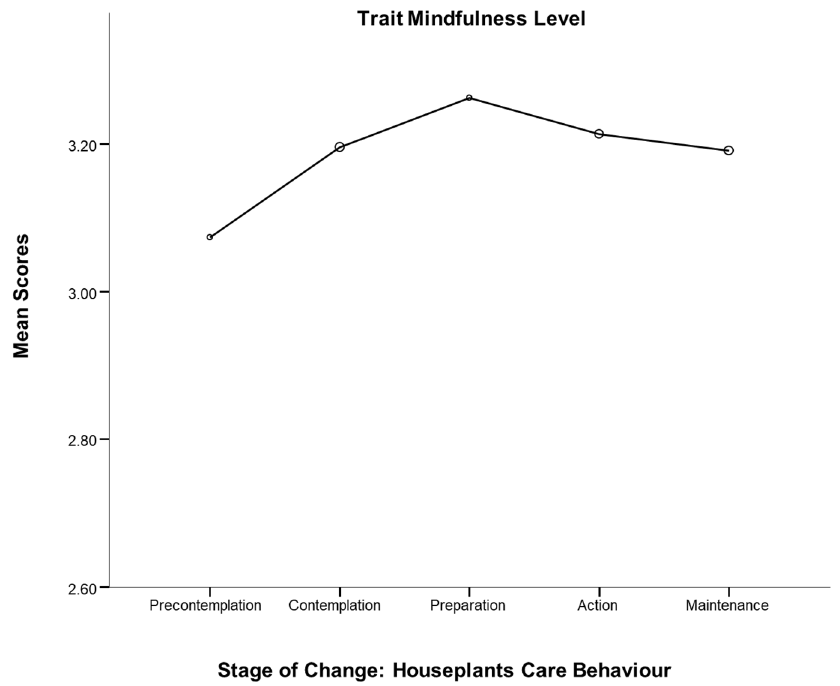
Figure 4. Houseplants care behaviour and mindfulness. For each subscale of FFMQ, results shown that only for observing (F = 3.61, p = 0.01) and for describing (F = 2.45, p = 0.05) were there statistically significant differences be- tween the five houseplant behaviour groups (see Figure 5).